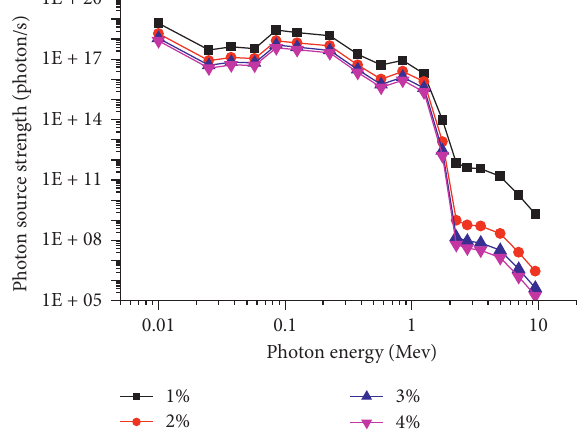
Figure 4: The photon source strengths under different